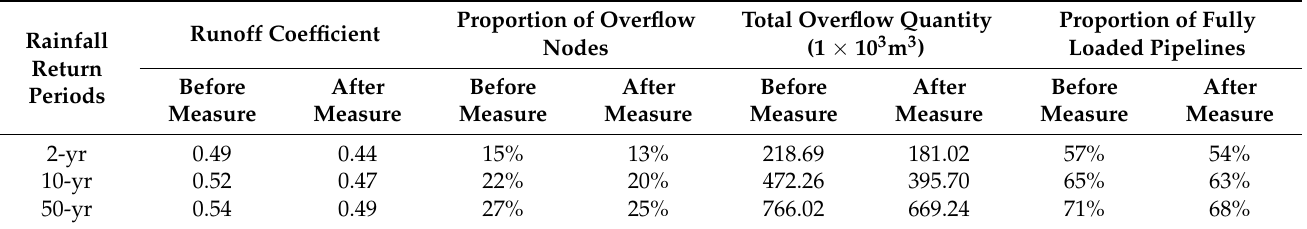
Table 8. Statistics analysis on the drainage capacity under different return periods.